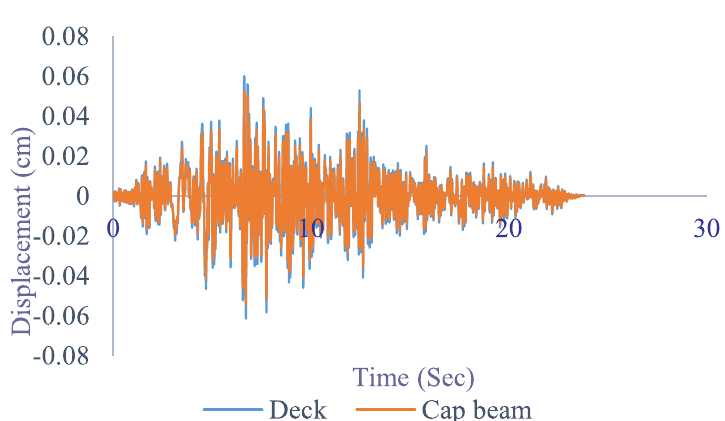
Fig. 13 The lateral displacement of points Deck and Cap beam in longitudinal direction (X) in model 1 under the Tabas earthquake